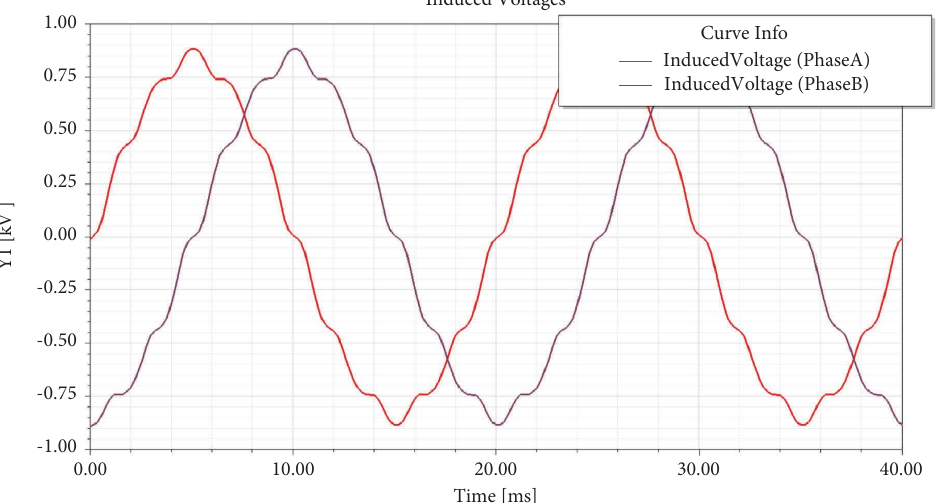
Figure 18: Back EMF curves of 4-pole 24-slot motor.